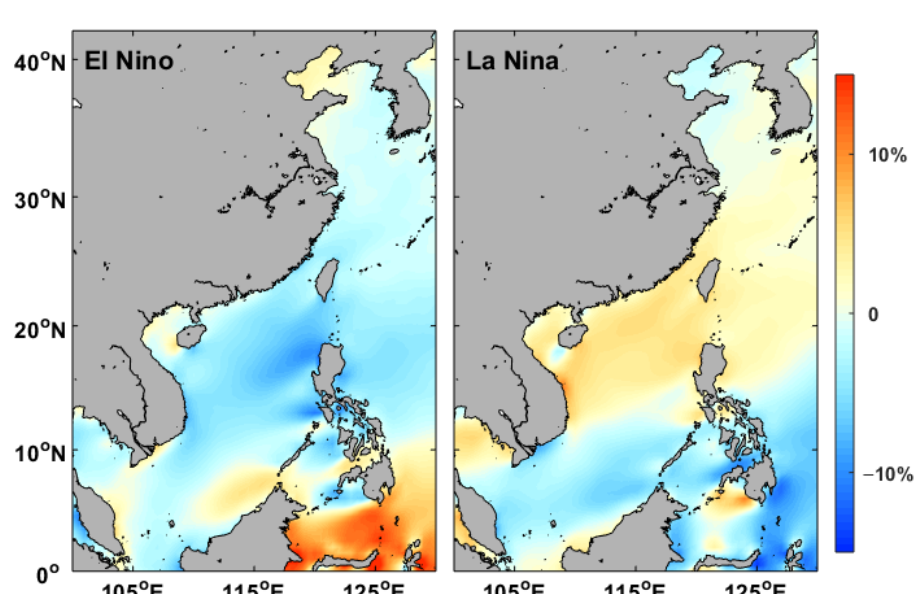
Figure 12. The percentage change in wind speed during El Niño and La Niña events between 1979 and 2016.